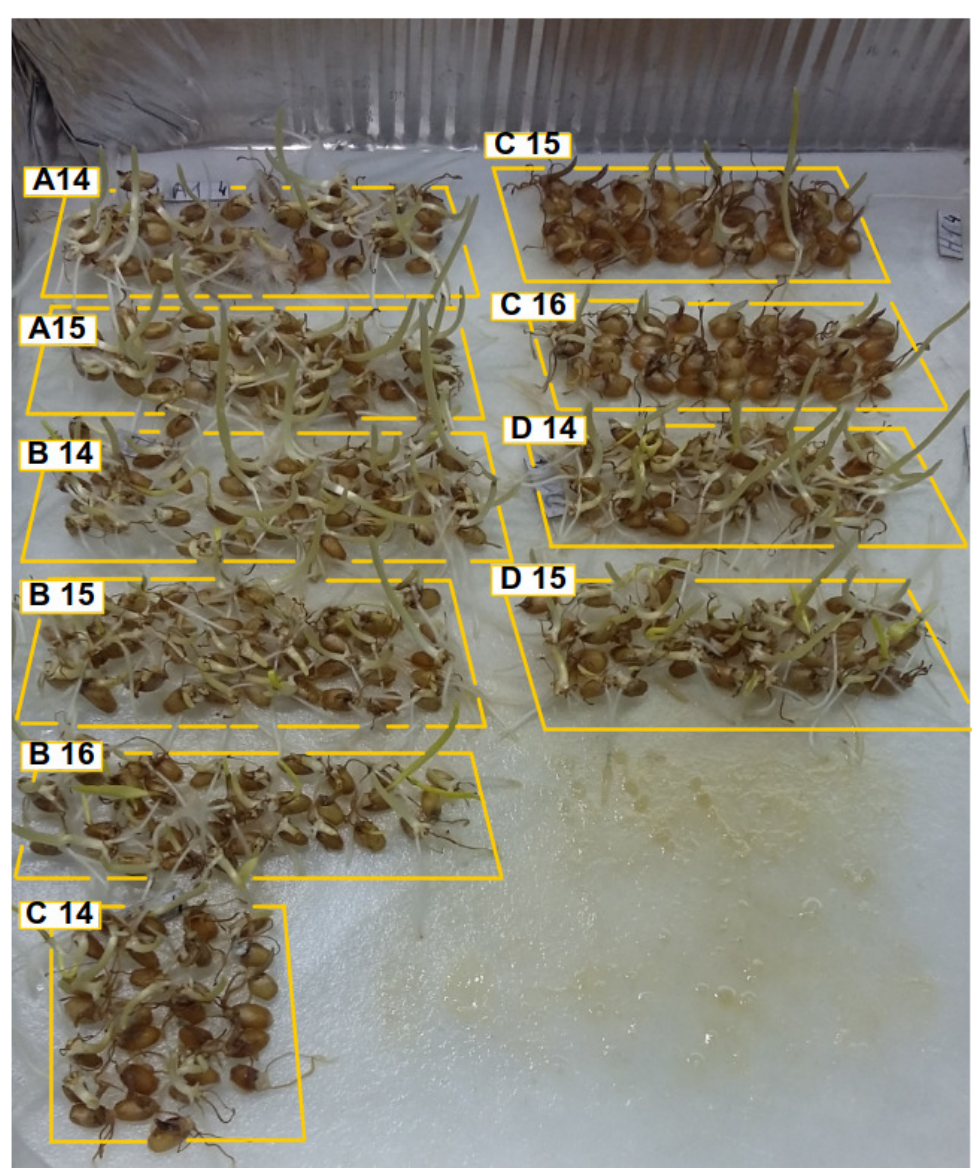
Figure 3. Location of samples for germination after freezing. Text indexes denote our internal labeling of variants and